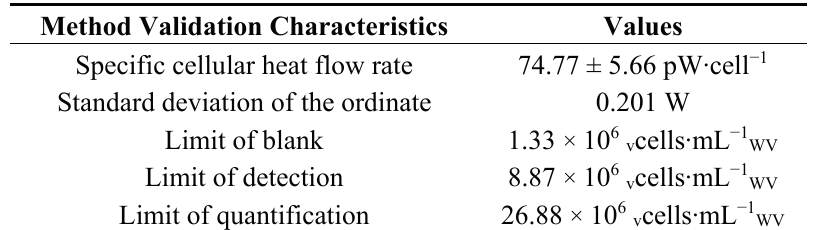
Table 3. Monitoring encapsulated CHO-DP12 cell cultures method validation.